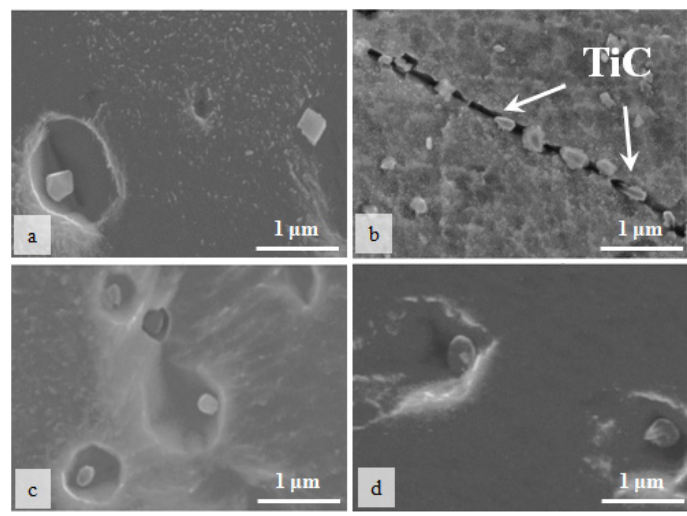
Figure 5. SEM images of the precipitates in ( a , b ) Monel K500 and ( c , d ) FM60 in ( a , c ) as-weld and ( b , d ) aged at 610 ° C conditions (travel speed of 500 mm/min).